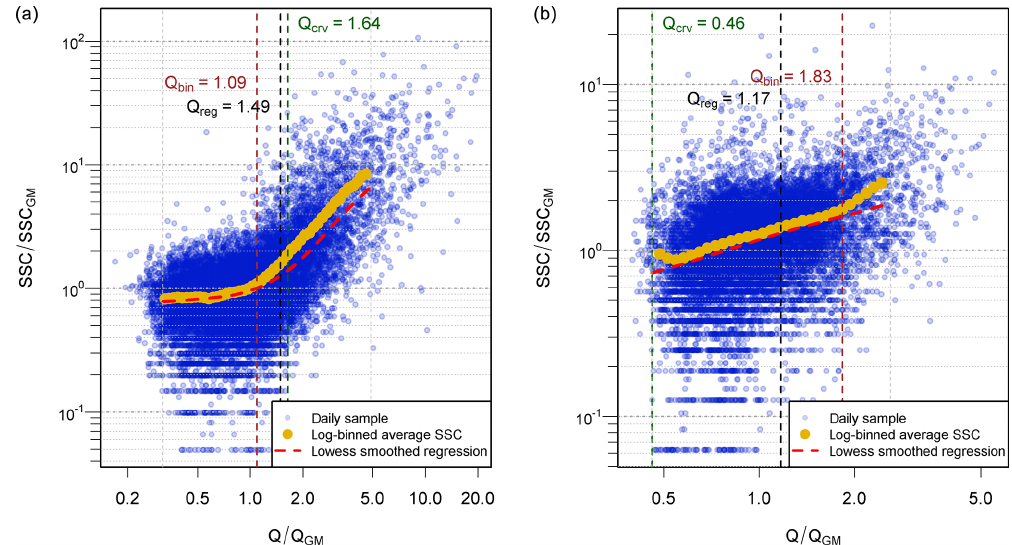
Figure 3. Rating curves of the stations at Rockenau (river Neckar, ID 222) (a) and Kachlet (river Danube, ID 103) (b) . For locations, see Fig. 1. Q crv , Q reg , and Q bin refer to the rating breaks derived using the maximum curvature of the lowess curve, the regression of the data points of the loess curve, and the regression of the binned averages (for more details, see the text).